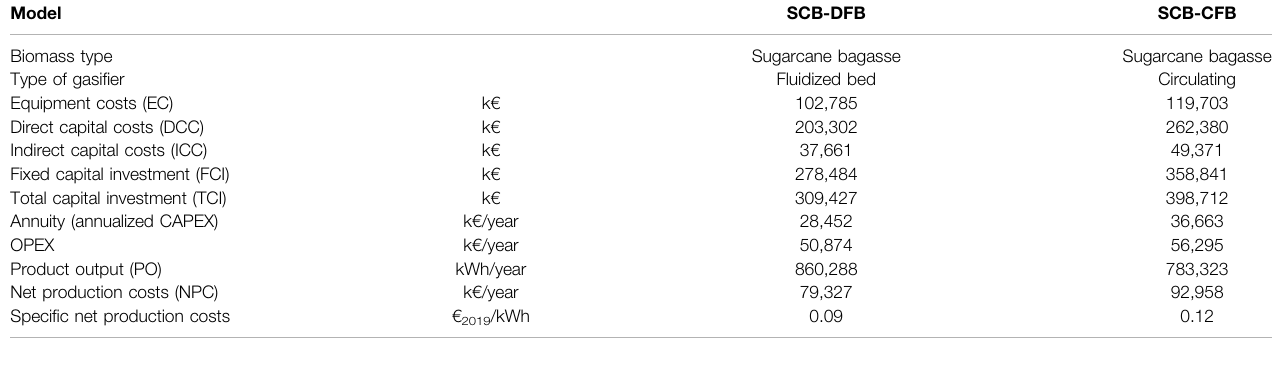
TABLE 3 | Techno-economic assessment evaluation.